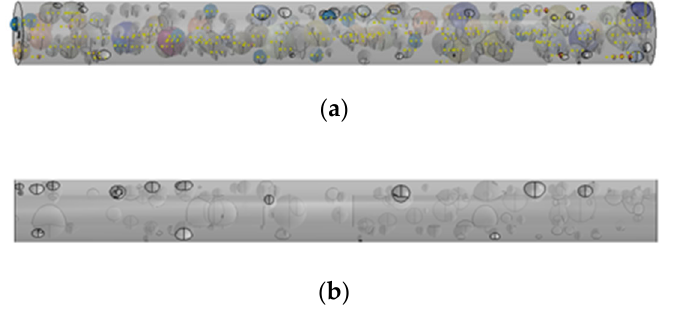
Figure 3. Defect model. ( a ) Preliminary defect model. ( b ) Defect model after Boolean operation.